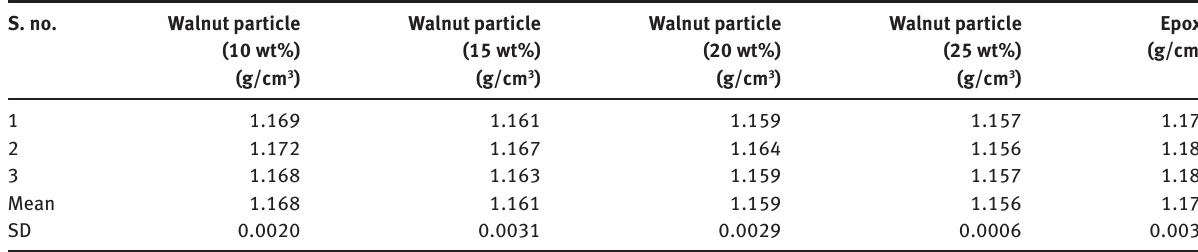
Table 1 Density of walnut particle reinforced composite.